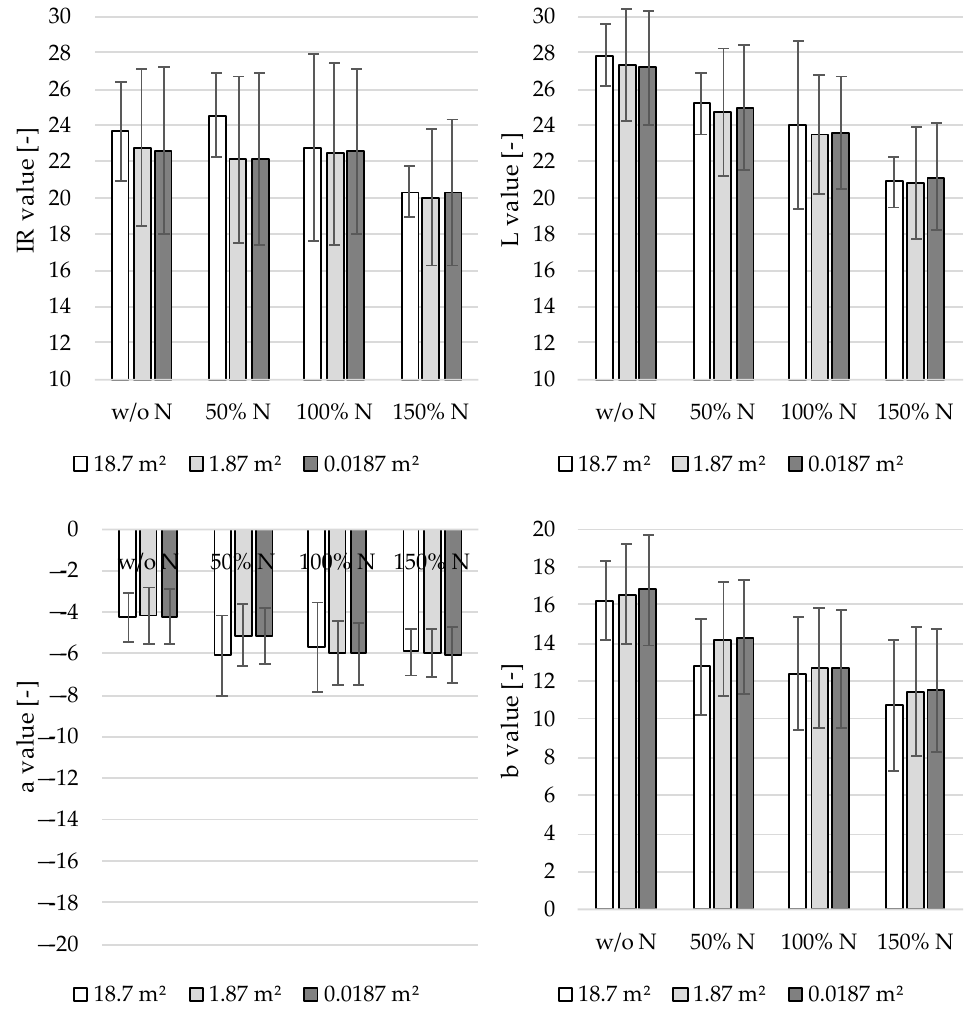
Figure 6. Reflection values of the sensor channels for BBCH 32 with variation of the detection areas.